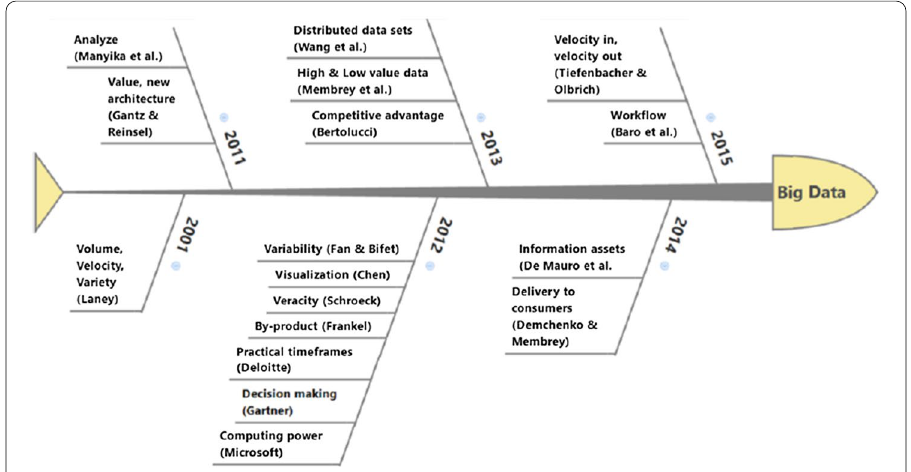
Fig. 1 The timeline of Big Data definitions